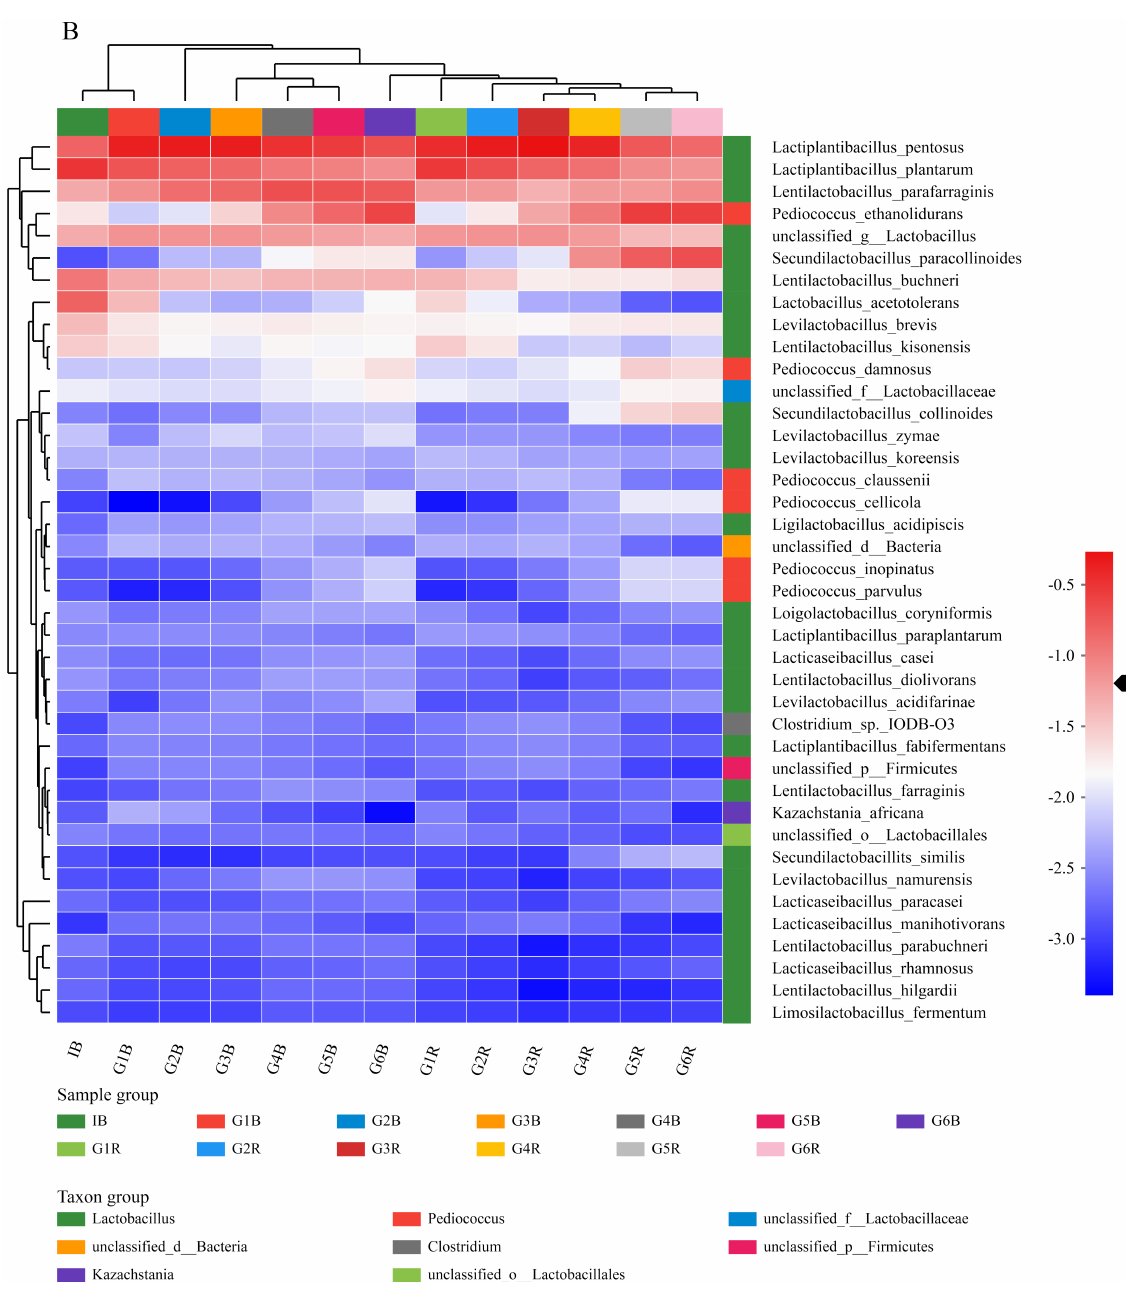
Figure 3. ( A ) The heatmap analysis of the top 40 microorganisms at the genus level. ( B ) The heatmap analysis of the top 40 microorganisms at the species